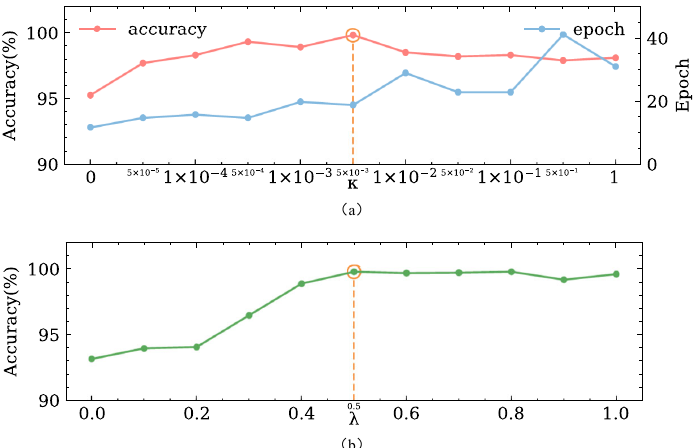
Figure 5. Diagnosis accuracies for the DDS dataset, respectively, achieved by ( a ) models with different κ and fixed λ = 0.5. ( b ) models with different λ and fixed K = 5 × 10 − 3